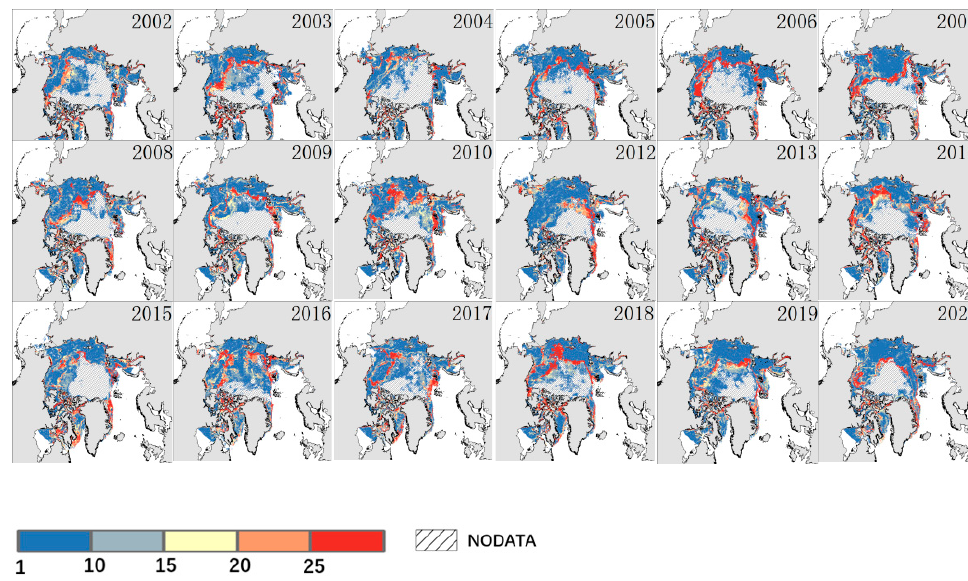
Figure 13. Number of days from breaking up to complete melting of sea ice in Kara Sea, Laptev Sea, East Siberian Sea, and Chukchi Sea from 2002 to 2020. The red dotted line is a linear fit of the mean days. The standard errors were 0.24, 0.26, 0.21, and 0.17, respectively, and passed the significance test ( p < 0.05). Table 9. Days from freezing up to complete freezing of Arctic sea ice, 2002 – 2020.